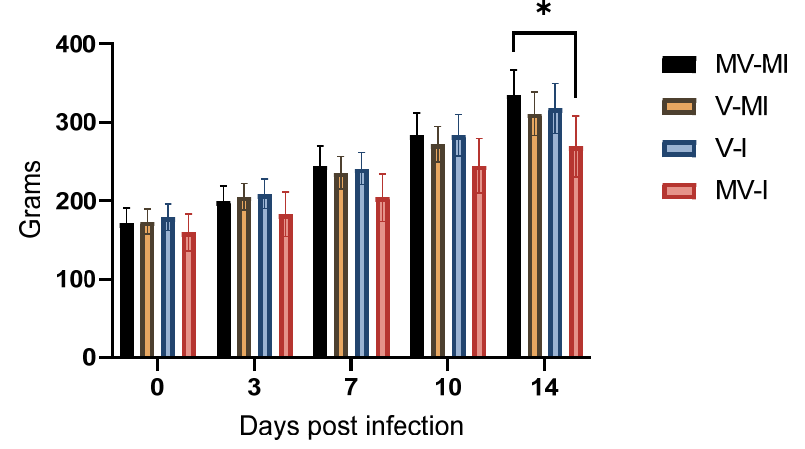
Figure 4. Bodyweight gains of experimental chickens at 0, 3, 7, 10 and 14 days post-infection (dpi). Data are presented as mean, and the error bars represent the standard error of means (SEM). Kruskal–Wallis test followed by Dunn’s multiple comparison test was used to identify group differences. * = p < 0.05.